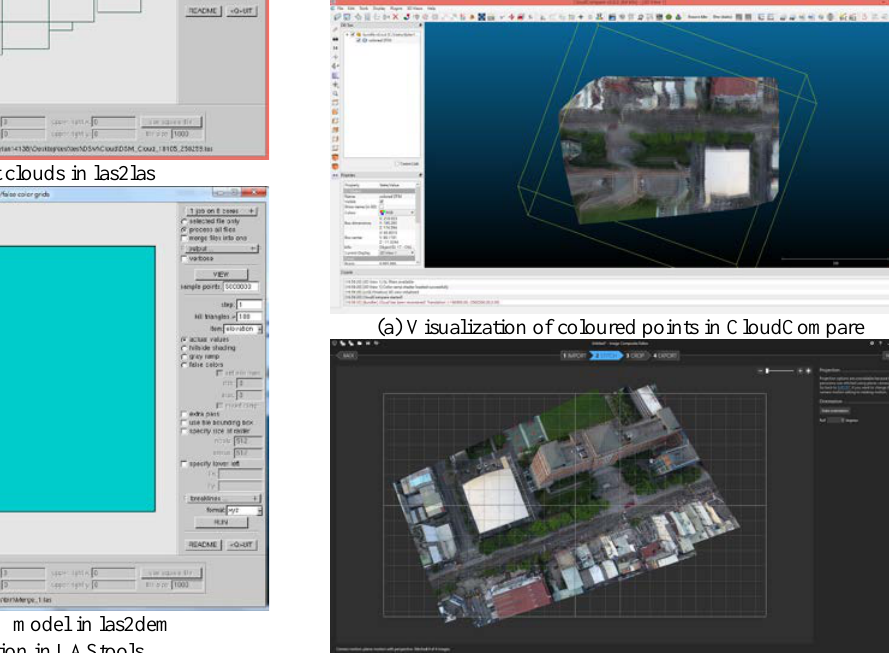
Figure 5. Process of image